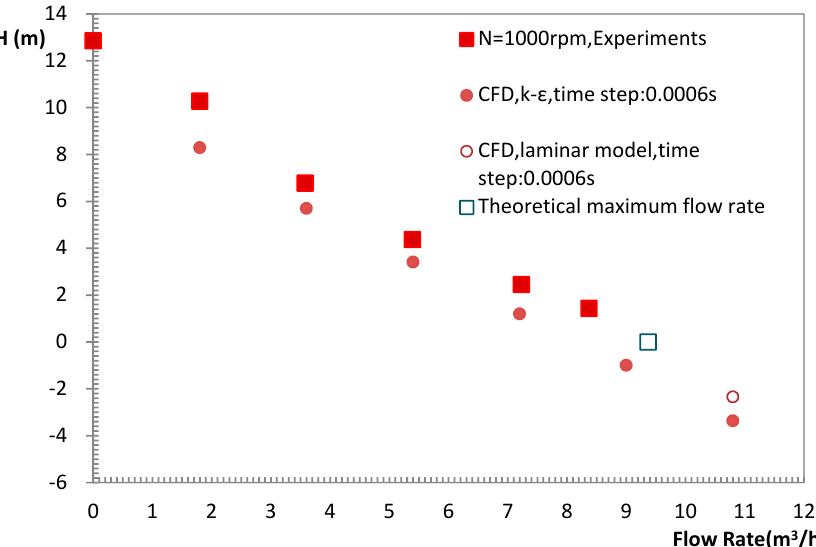
Figure 13. Comparisons between experimental and CFD results. N = 1000 rpm.